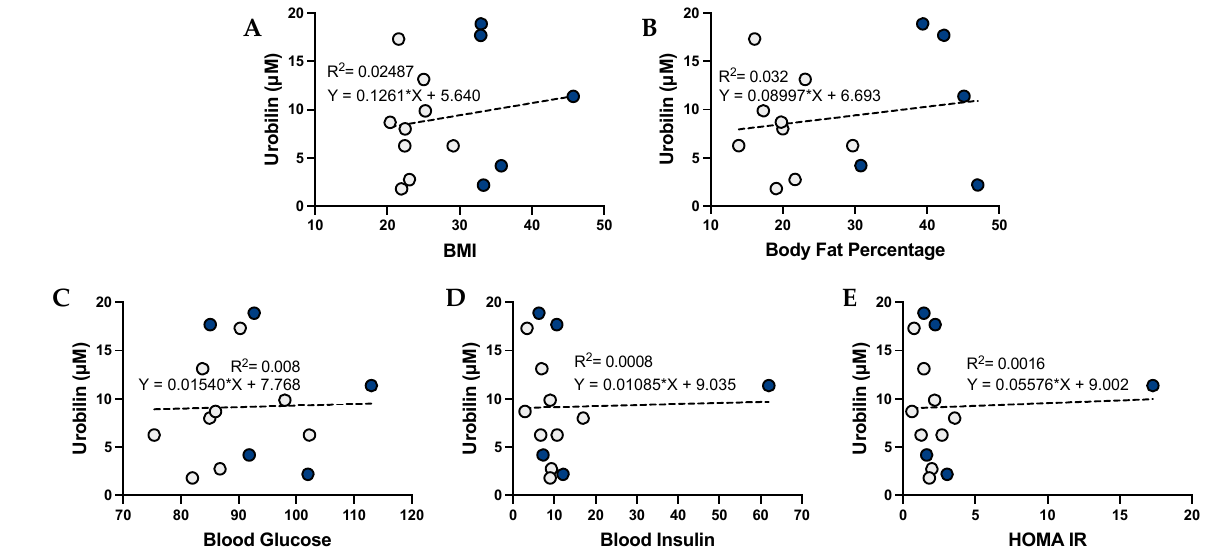
Figure 4. Urobilin levels and correlations with metabolic phenotypes in men . Comparisons of metabolic phenotypes in men with plasma urobilin levels for ( A ) BMI, ( B ) body fat percentage, ( C ) blood glucose, ( D ) blood insulin, and ( E ) HOMA IR. The data were plotted as dot plots, linear regression was calculated, and the slope of the line was used to determine the relationship and the robustness of the data. Blue circles are for obese men, and gray circles are for their lean counterparts.